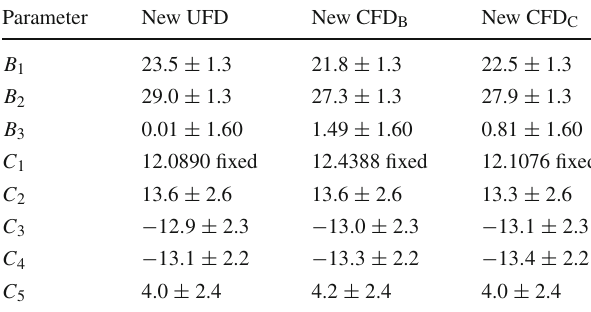
Fig. 17 New φ 0 phase obtained after extracting the data from [8] by 0 using our UFD for the g 0 partial wave 2 Table 8 Parameters of the new φ 0